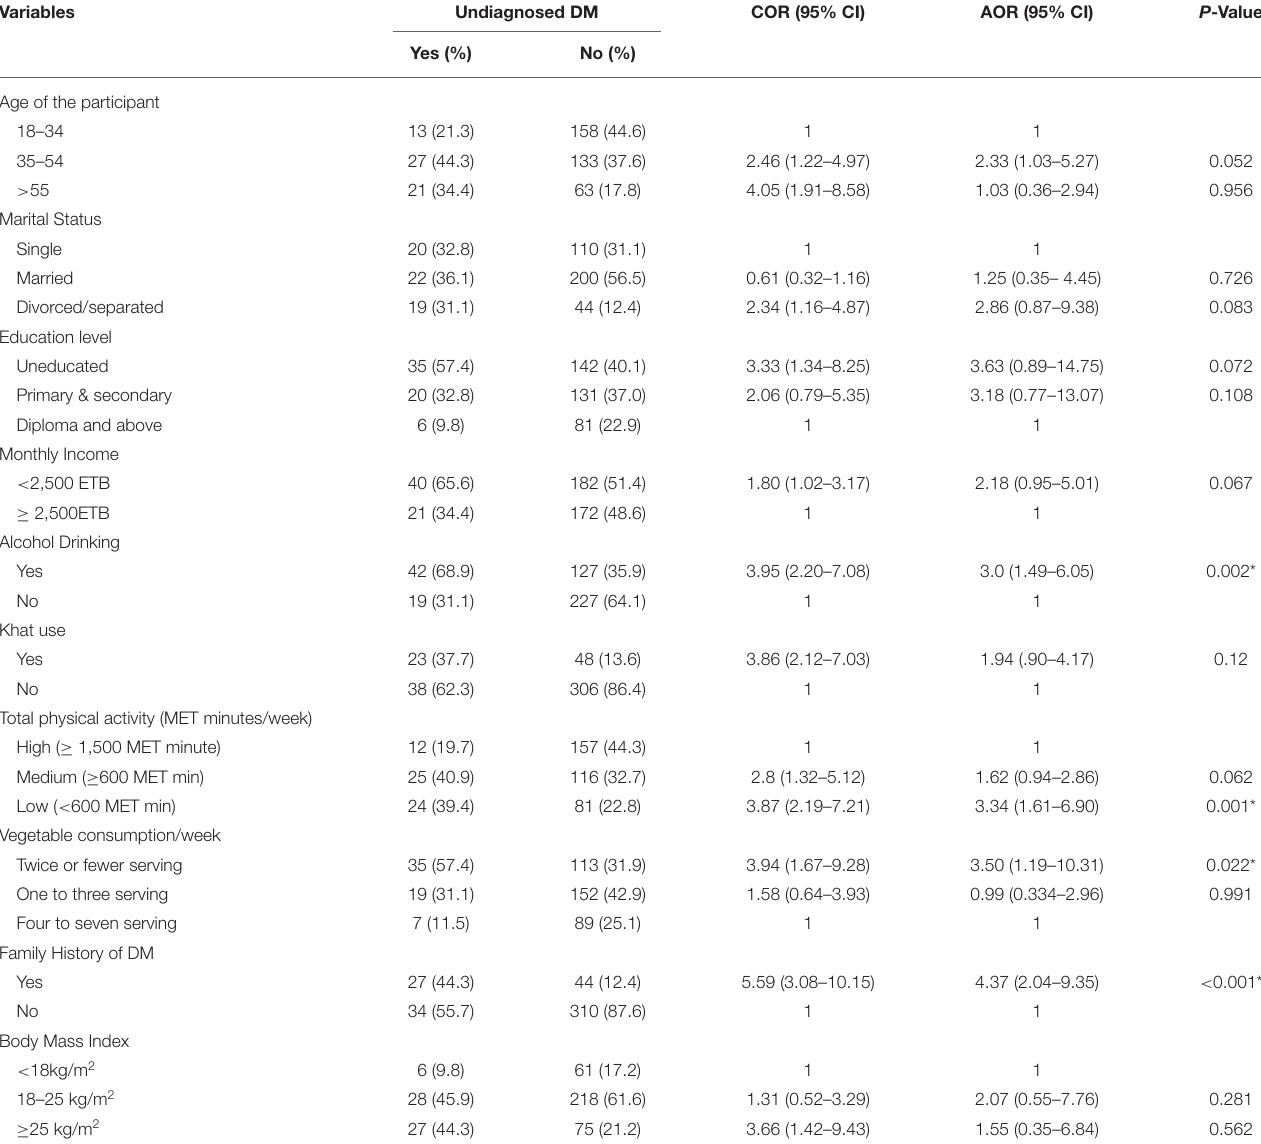
TABLE 4 | Multivariable analysis of different variables with undiagnosed DM in Menja community, Southwest Ethiopia, 2021 ( N = 415).